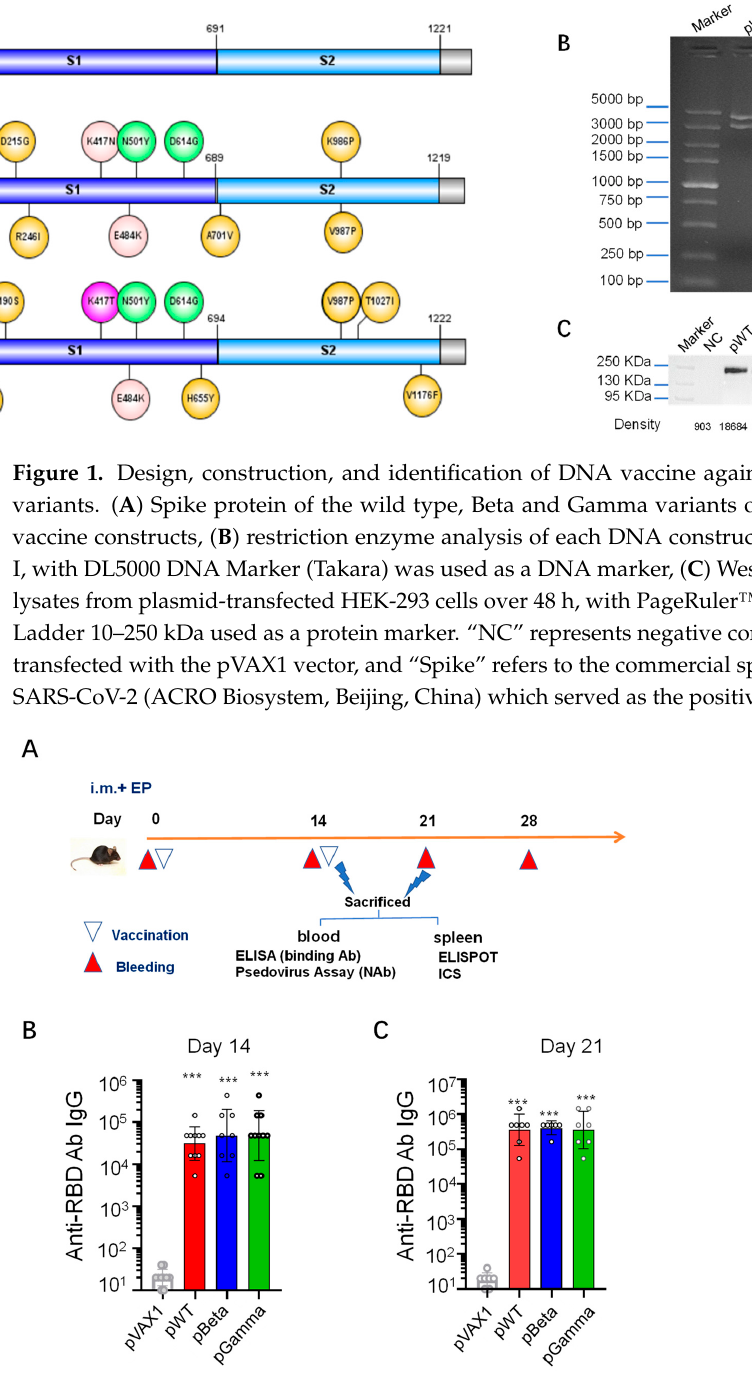
Figure 2. Vaccination schedule and binding antibody against RBD in sera from DNA vaccine immunized C57BL/6 mice. ( A ) Mice were intramuscularly immunized twice at two-week intervals with DNA vaccine at a dose of 20 μ g in 50 μ L PBS at the quadriceps following electroporation, and sacrificed on days 14 and 21. Titers of anti-RBD specific IgG antibodies were measured using ELISA and expressed as geometric mean ± SD, ( B ) RBD-binding antibody titer elicited by pWT ( n = 10), pBeta ( n = 8) and pGamma ( n = 10) on day 14, ( C ) RBD-binding antibody titer elicited by pWT ( n = 7), pBeta ( n = 6) and pGamma ( n = 7) on day 21. *** denotes extremely significant difference ( p < 0.001) compared with pVAX1.